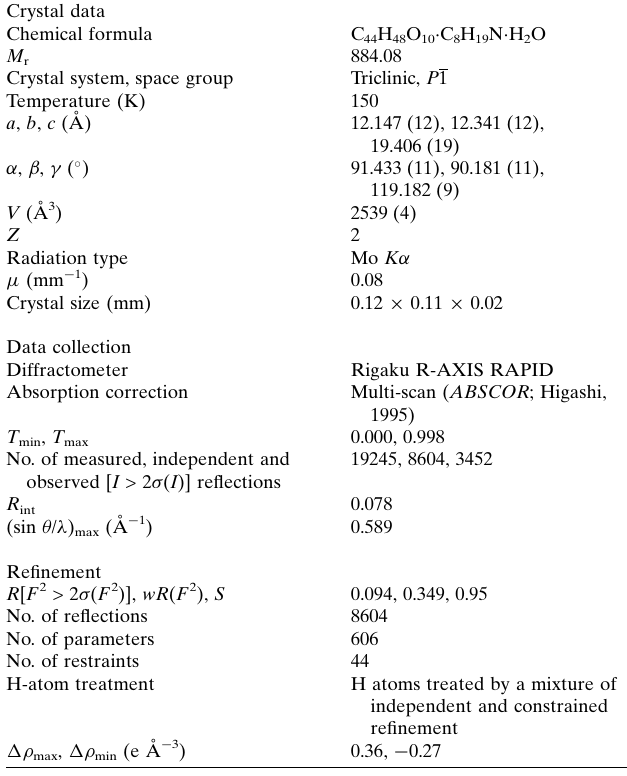
Table 3 Experimental details. Crystal data Chemical formula